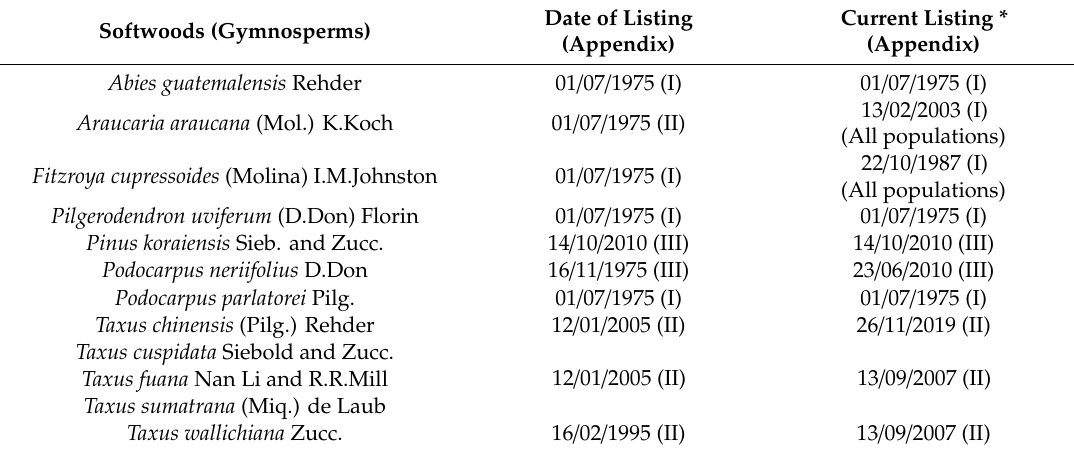
Table 1. List of species used in this